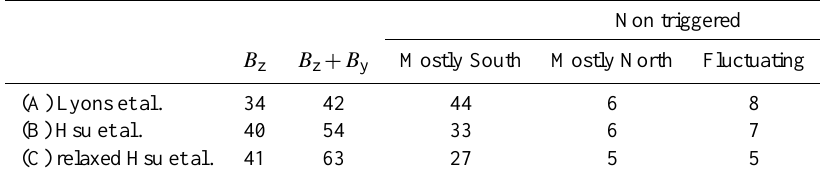
Table 3. Same as Table 1 but for the large dispersionless